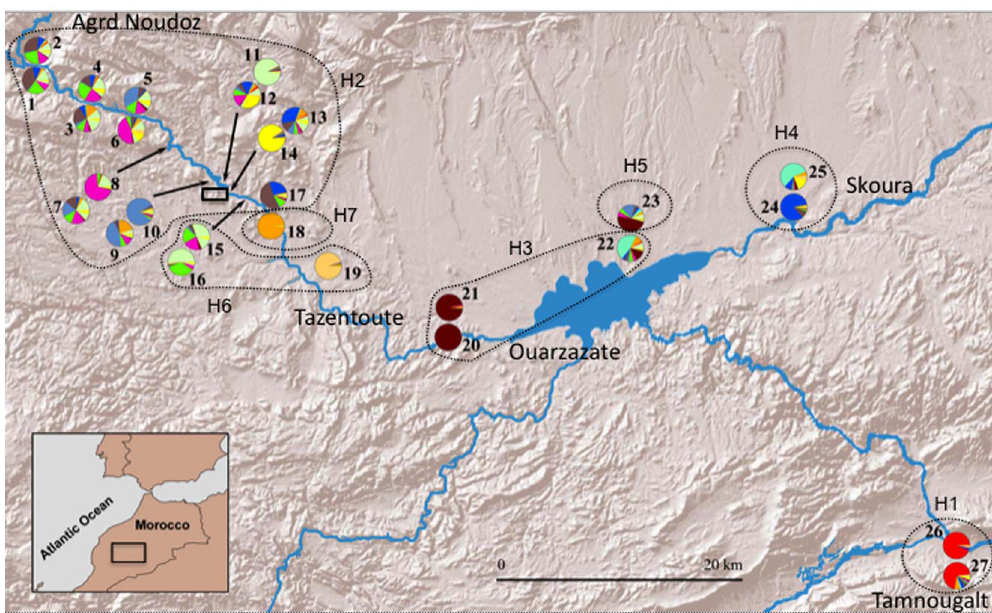
Figure 1. Map of C.emmae sampled nest localities across its distributional range (transect) in Morocco near Ouarzazate in 2010. Pie charts are Bayesian estimates of the population structure (log likelihood ln P(D/K). saturation at K=13) based on microsatellite variation of all 27 sites sampled localities. Dashed areas indicate mitochondrial haplotypes (indicated as H1-7) as inferred from the Medium Joining network. The square by the wadi indicates the location of the fine-scale sampling plot at 1.8 km from Ait Ibourk. doi:10.1371/journal.pone.0072941.g001 (Table 2). Ten workers from one nest shared the same paternal alleles supporting the possibility of rare monandry or strong skew between fathers. The average probability of non-detection due to two males bearing the same alleles at all loci was negligible ( P non- 2 14 ). Moreover, queens’ male mates were unrelated to detect = 7.70 each other (relatedness among a queen male mates: r m- 6 0.03 (mean 6 SE jackknife ) not significantly different from m = 0.01 0 ( t = 0.333, N= 63, P = 0.74)).